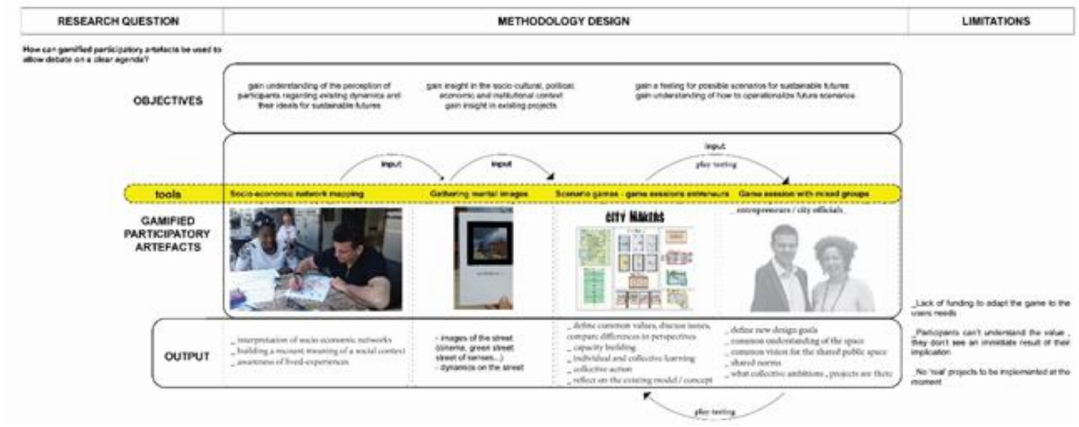
Figure 3. Participatory mapping process